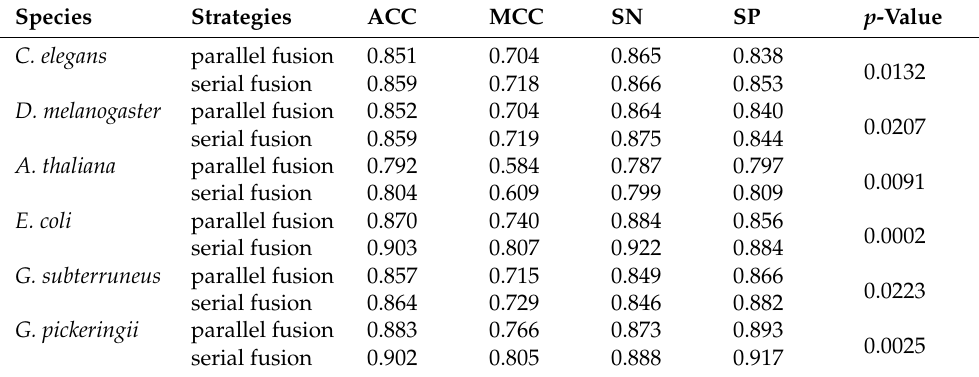
Figure 7. Performance of the two fusion strategies on the Accuracy and Matthews correlation coefficient metrics. Table 3. Comparison between the parallel fusion strategy and serial fusion